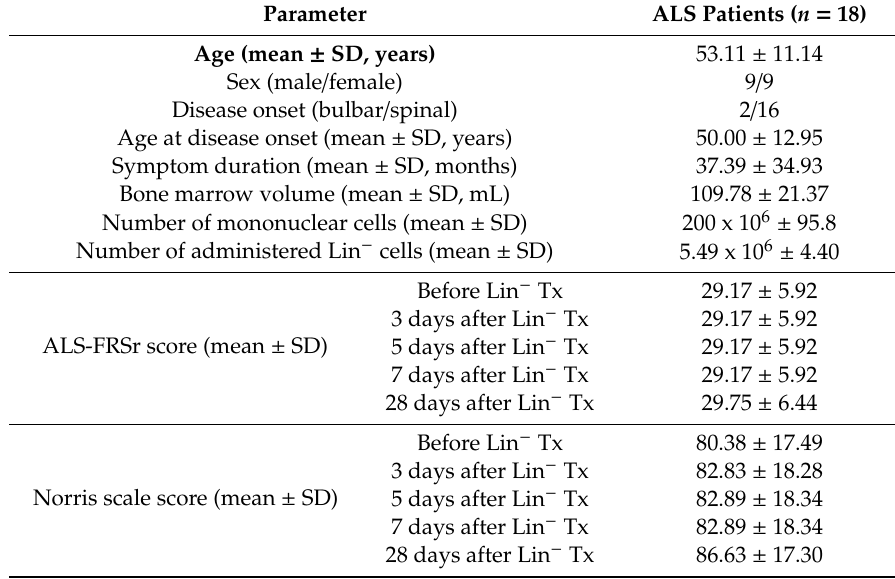
Table 3. Characteristic of studied group with ALS-FRSr and Norris scale results. Tx: